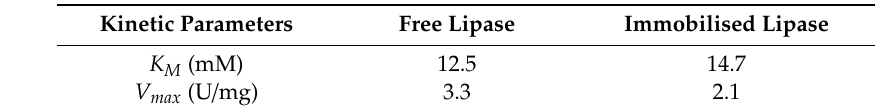
Table 2. Kinetics parameters of immobilised and free lipase using p -NPP substrate. All experiments in this study were carried out in triplicate with standard deviation below 5%.